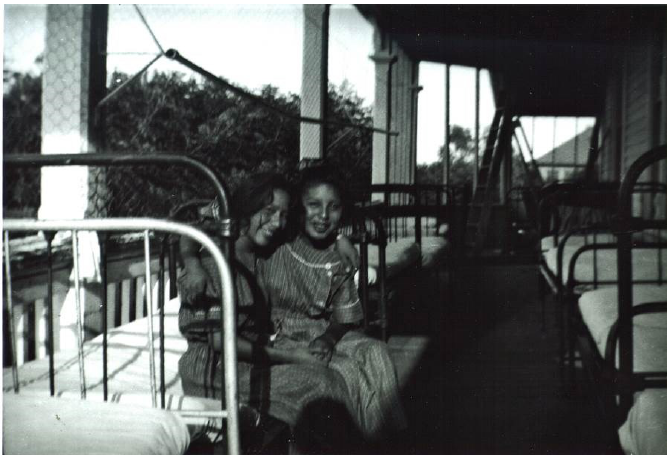
Figure 19. Deoma Doyebi (Kiowa) and Ethel Roberts (Wichita), ca. 1916. Photograph